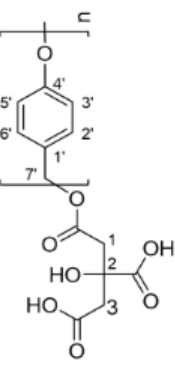
Figure 3. The putative repeating unit of GEP-1 . Table 3. Chemical shifts of main residues of GEP-1 .